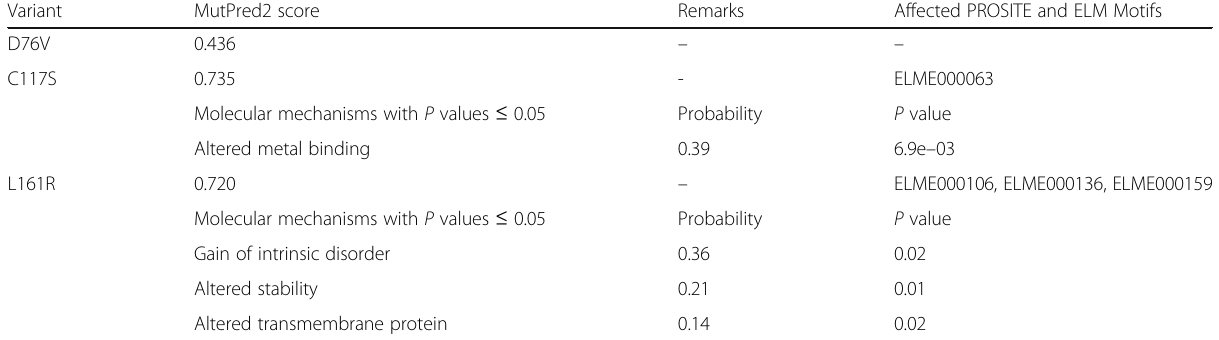
Table 3 MutPred prediction for the most deleterious missense variants observed in LEP gene Variant